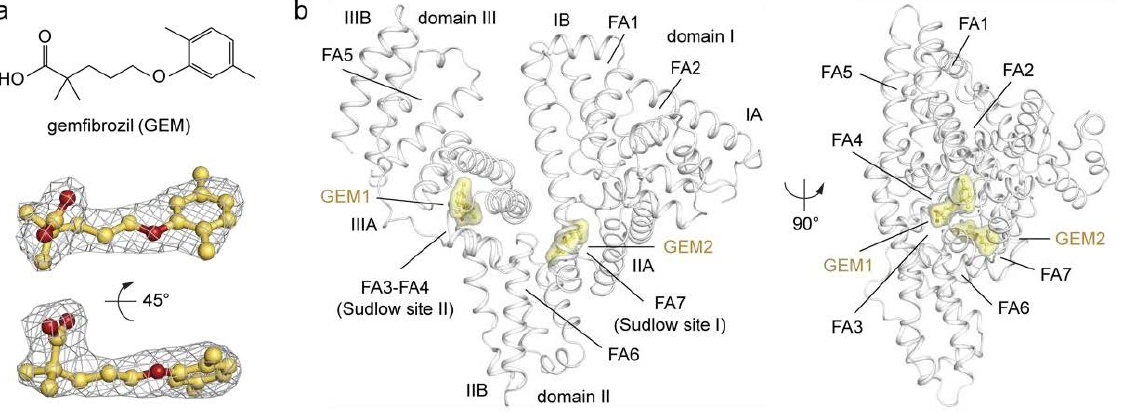
Figure 1. Structure of HSA in complex with GEM. ( a ) Chemical structure (top) and composite omit maps depicting the ( F o − F c ) electron density (bottom) of GEM1 ligand contoured at 2.5σ and shown in two orientations (90° rotation); ( b ) crystal structure of the HSA-GEM complex (white) shown in two orientations (90° rotation, PDB identification code: 7QFE). The structure of HSA is organised in homologues domains (I, II, and III), subdomains (A and B), fatty acids binding sites (FA), and Sudlow ’s binding sites. The α -helices of HSA are represented by cartoon loops (white). Bound GEM1 and GEM2 ligands are shown in a ball-and-stick representation with a semi-transparent van der Waals surface (yellow) and coloured by atom type (GEM: carbon = yellow orange, oxygen = firebrick). The electron density of GEM ligands is shown as a grey mesh. The three-dimensional structure models were generated and rendered using Pymol [29].